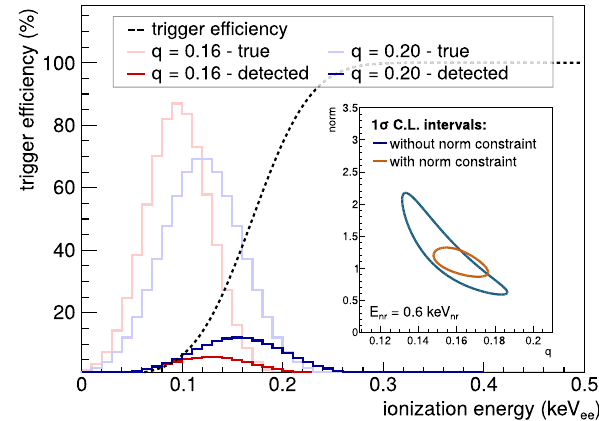
Fig. 9 Data selection for the coincidence analysis based on the time difference between a LS and a HPGe signal for two different expected nuclearrecoil distributions (red at4.9keV nr andgray at 0.6keV nr ). The energy reconstructed in the HPGe detector is represented on the y-axis. Correlatedsignalsare selectedfor Δ T < 1 . 6 μ s (blue line)enclosingthe smearing of the distributions at low energy, whereas accidental coinci- dences are estimated in 10 windows starting from Δ T > 3 . 2 μ s (yellow line)